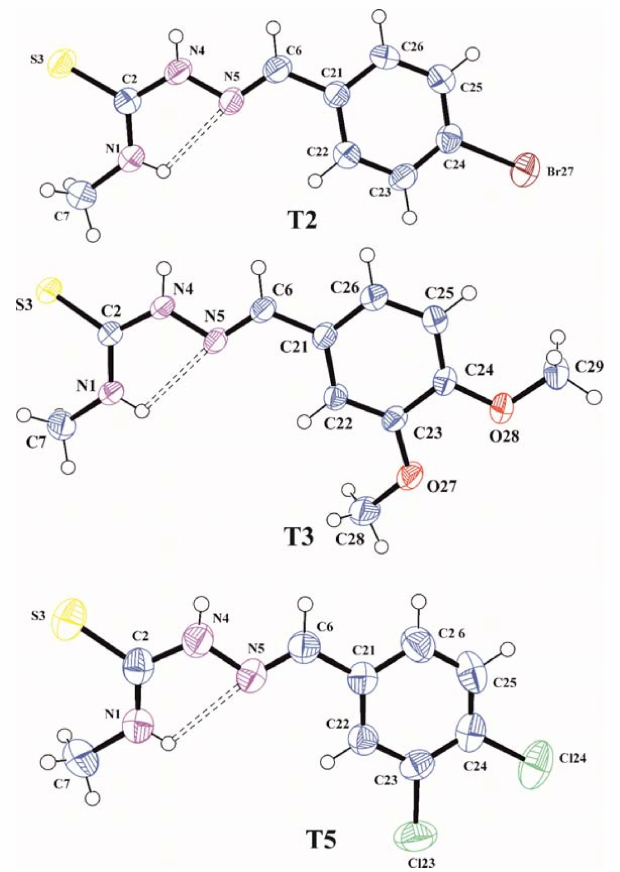
Figure 1. The molecular structures of T2, T3, and T5 with atom label ligand displacement ellipsoids (30% probability). The intramolecular hydrogen bond is shown as dashed line. The C2=S3, N4–N5, and N5=C6 bond lengths of 1.686(4), 1.373(4), and 1.266(5) Å in T2, 1.6896(13), 1.3809(14), and 1.2766(17) Å in T3 and 1.693(3), 1.375(3), and 1.272(3) Å